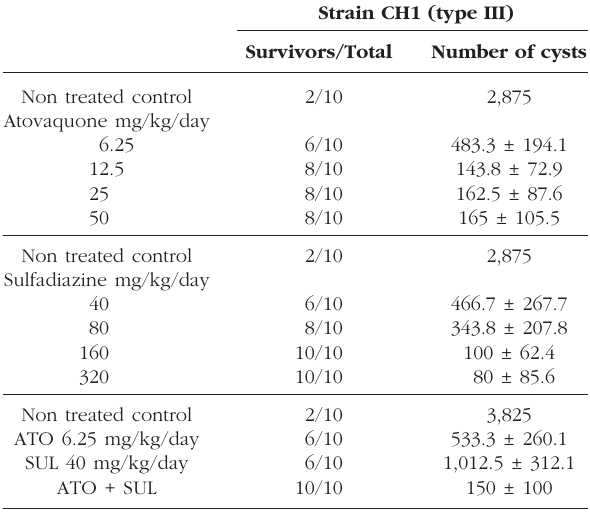
Table V. – Survival and number of brain cysts in mice infected with CH1 strain of T. gondii and treated with different doses of atova- quone (ATO), sulfadiazine (SUL) or drug association (ATO + SUL).